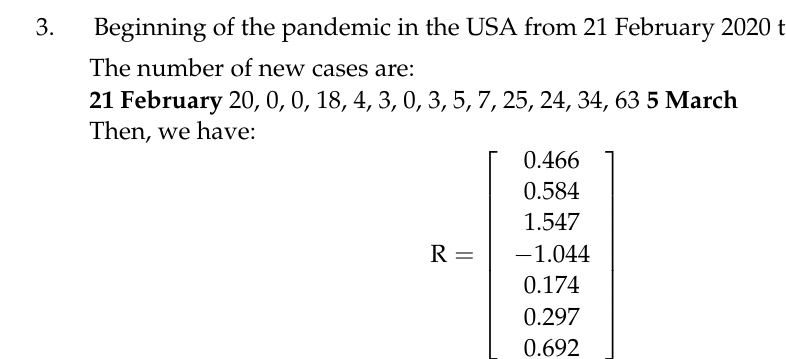
Figure A3. Values of the daily reproduction numbers R j along the period of contagiousness of length 7